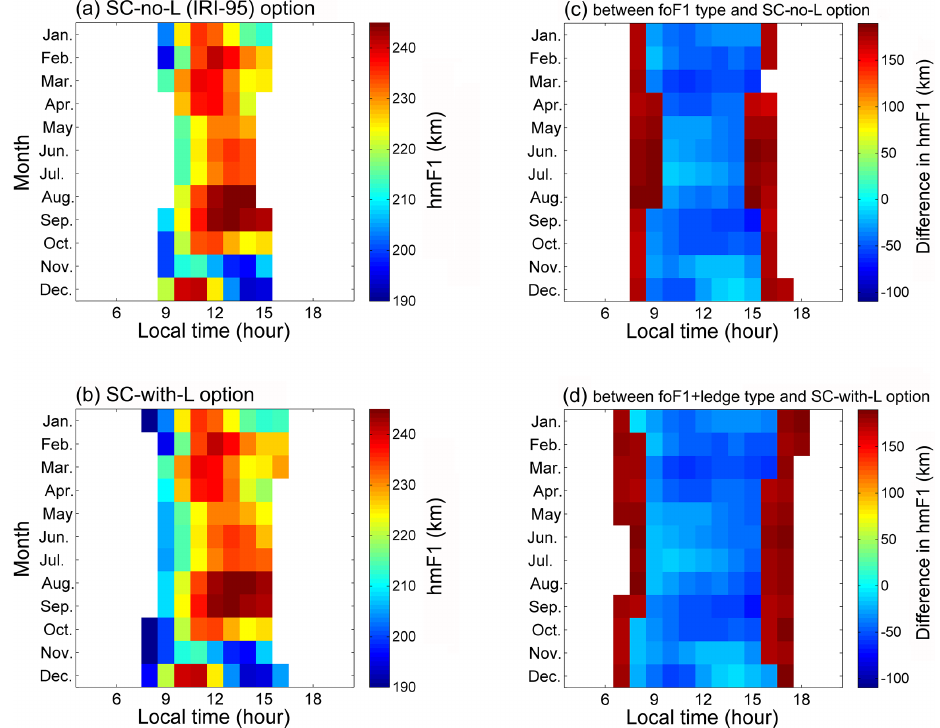
Figure 6. The monthly median hm F1 values for (a) SC-no-L and (b) SC-with-L options, modeled by IRI-2012 with the B0 choice of ABT- 2009, during January–December 1996. The differences in hm F1 (c) between fo F1 type and SC-no-L option, and (d) between fo F1 + ledge type and SC-with-L option are